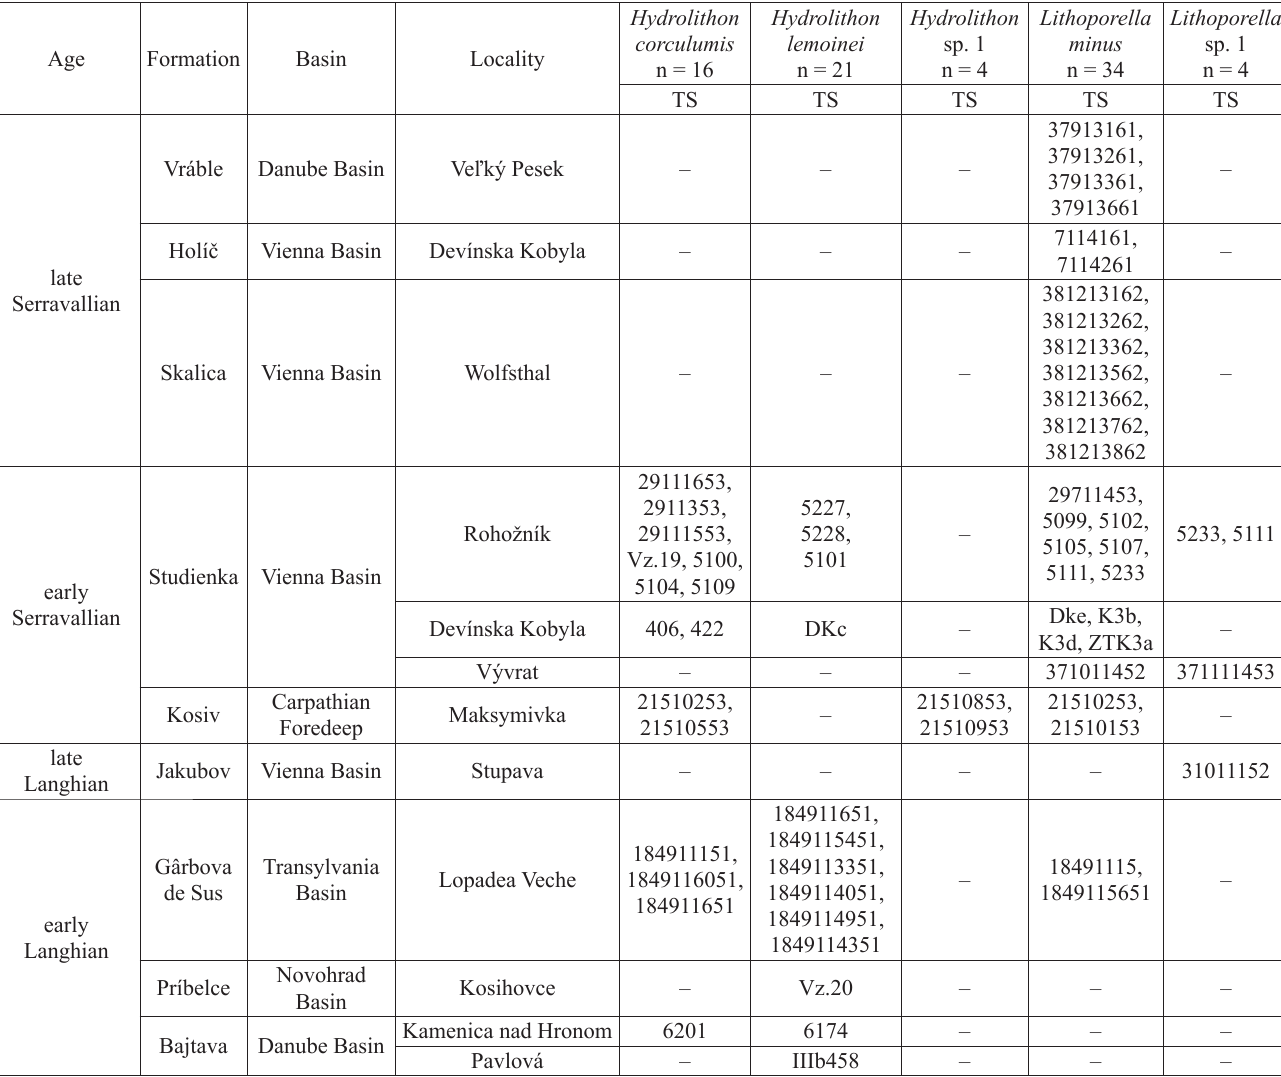
Table 2. List of the thin sections containing identified specimens, chronostratigraphy and litostratigraphic units. Abbreviations: n, number of specimens; TS, thin section; “–” not